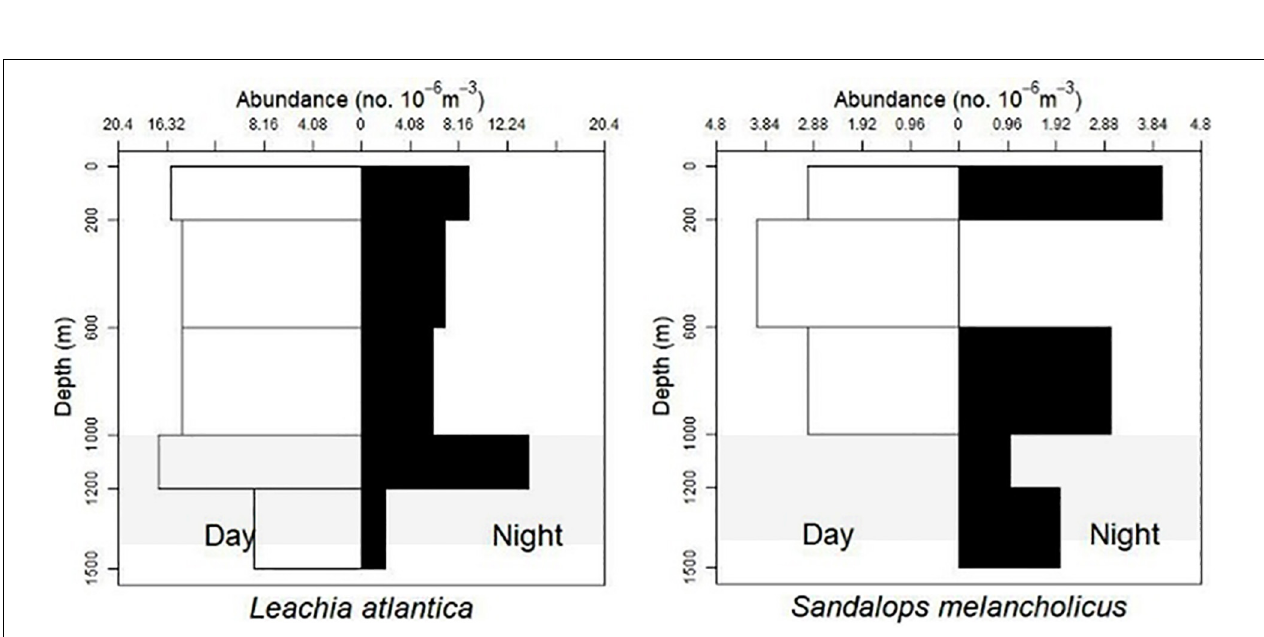
FIGURE 7 | Vertical distribution patterns unclassified. L. atlantica , n = 110; S. melancholicus , n = 20; shaded region indicates the deep oil plume zone.